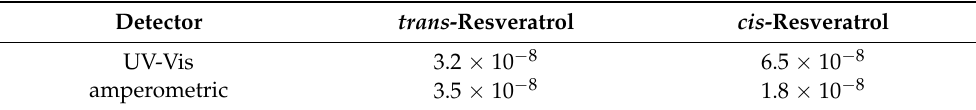
Table 8. LODs (mol L − 1 ) of UV-Vis detector ( λ at 306 nm for trans -resveratrol and 286 nm for cis -resveratrol) and amperometric